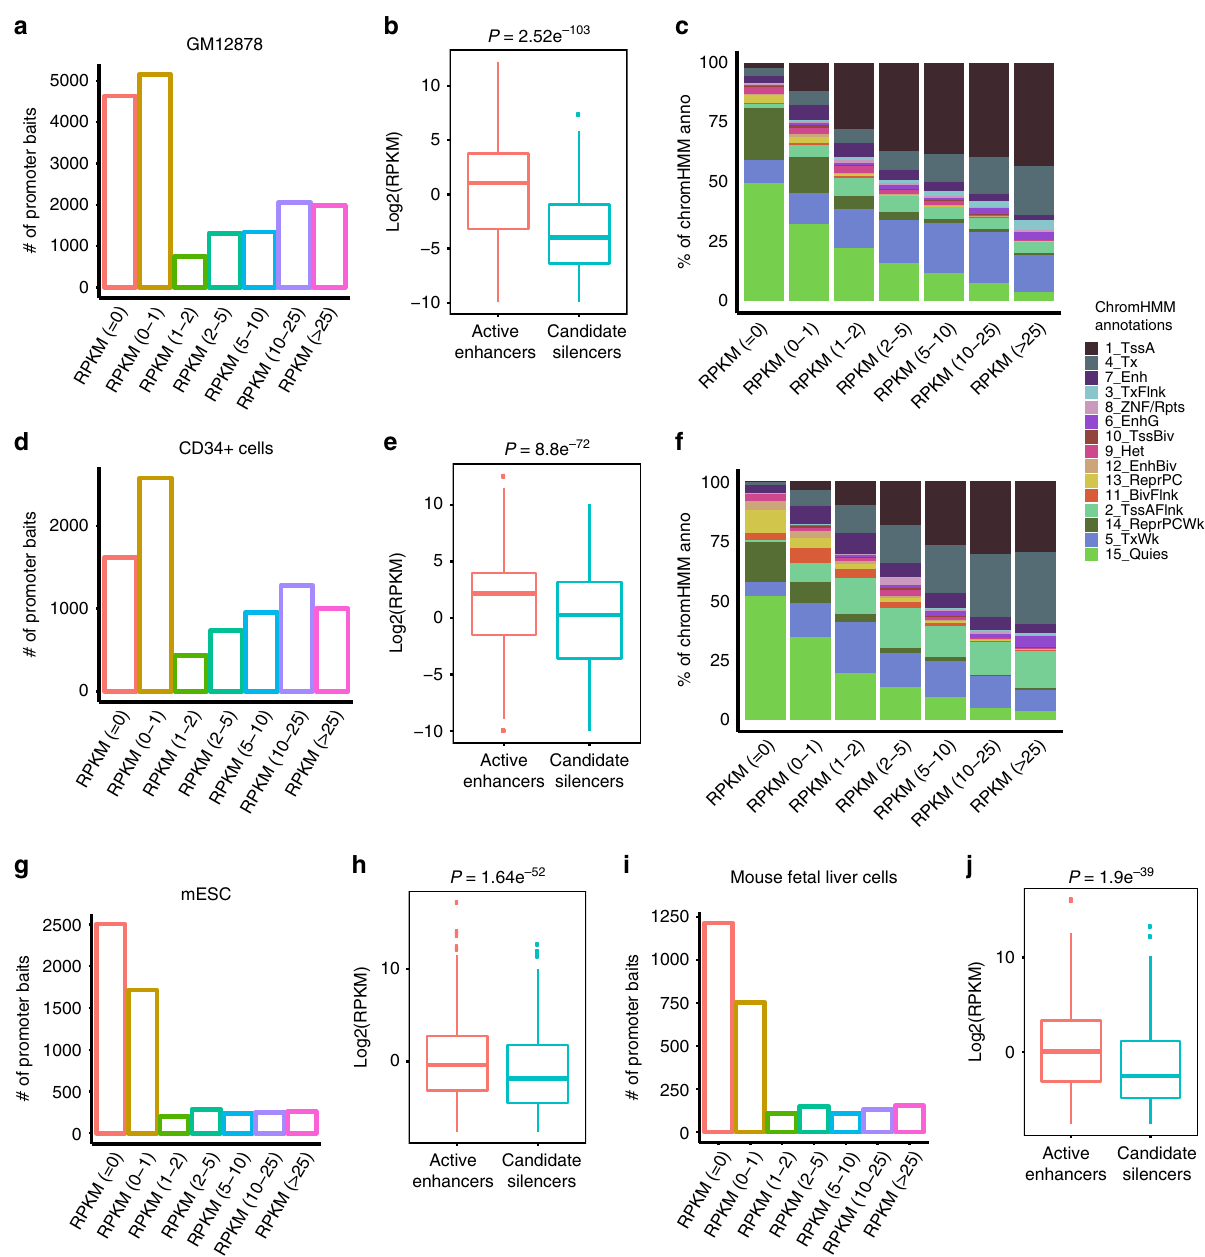
Fig. 5 3D Genome interactions of candidate silencer elements. a Bar plot presenting the counts of genes expressed at different expression levels (RPKM) interacting with candidate silencer elements in GM12878 cells. b Box plot comparing the expression levels (RPKM) of genes interacting with candidate silencer elements and active enhancers in GM12878 cells. c Bar plot showing the distribution of chromHMM annotations for TSS of genes interacting with candidate silencer elements in GM12878 cells. d Bar plot presenting the counts of genes expressed at different expression levels (RPKM) interacting with candidate silencer elements in CD34 + cells. e Box plot comparing the expression levels (RPKM) of genes interacting with candidate silencer elements and active enhancers in CD34 + cells. f Bar plot showing the distribution of chromHMM annotations for TSS of genes interacting with candidate silencer elements in CD34 + cells. g Bar plot presenting the counts of genes expressed at different expression levels (RPKM) interacting with candidate silencer elements in mouse embryonic cells (mESCs). h Box plot comparing the expression levels (RPKM) of genes interacting with candidate silencer elements and active enhancers in mESCs. i Bar plot presenting the counts of genes expressed at different expression levels (RPKM) interacting with candidate silencer elements in mouse fetal liver cells (FLCs). j Box plot comparing the expression levels (RPKM) of genes interacting with candidate silencer elements and active enhancers in FLCs. P -values computed by one-tailed Wilcoxon rank-sum test. In the box plots, bounds of the box spans from 25 to 75% percentile, center line represents median, and whiskers visualize 5 and 95% of the data